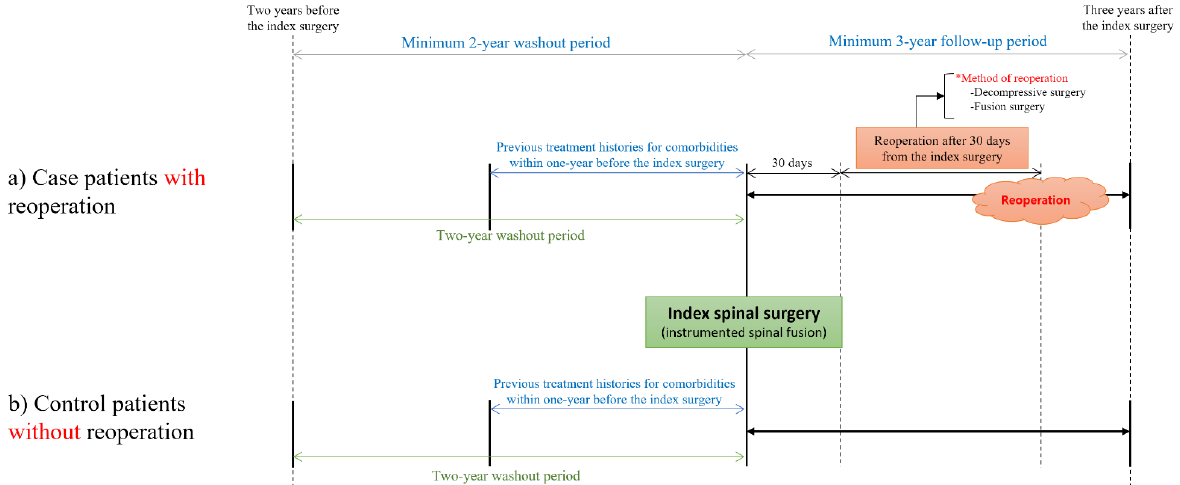
Figure 2. Definitions of cases and controls. * Reoperation was defined as subsequent surgery, which only included decompressive or fusion surgery.